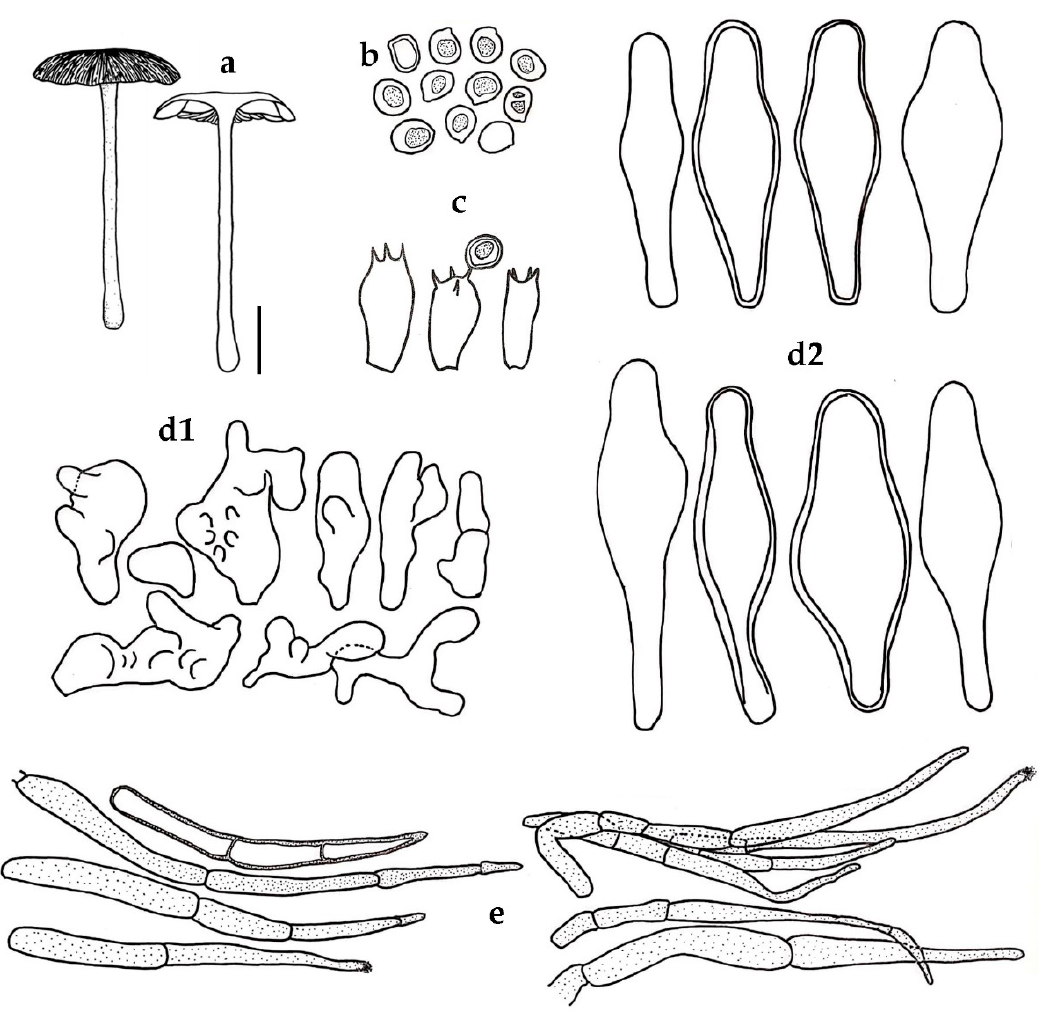
Figure 4. Pluteus chandrasrikuliae BKF 10214 (holotype): ( a ) basidiomes; ( b ) basidiospores; ( c ) basidia; hymenial cystidia: ( d1 ) irregular shaped cystidia; ( d2 ) lageniform cystidia; ( e ) pileipellis element. Scale bars: ( a ) = 20 mm; ( b , c ) = 10 μ m; ( e ) = 25 μ m.